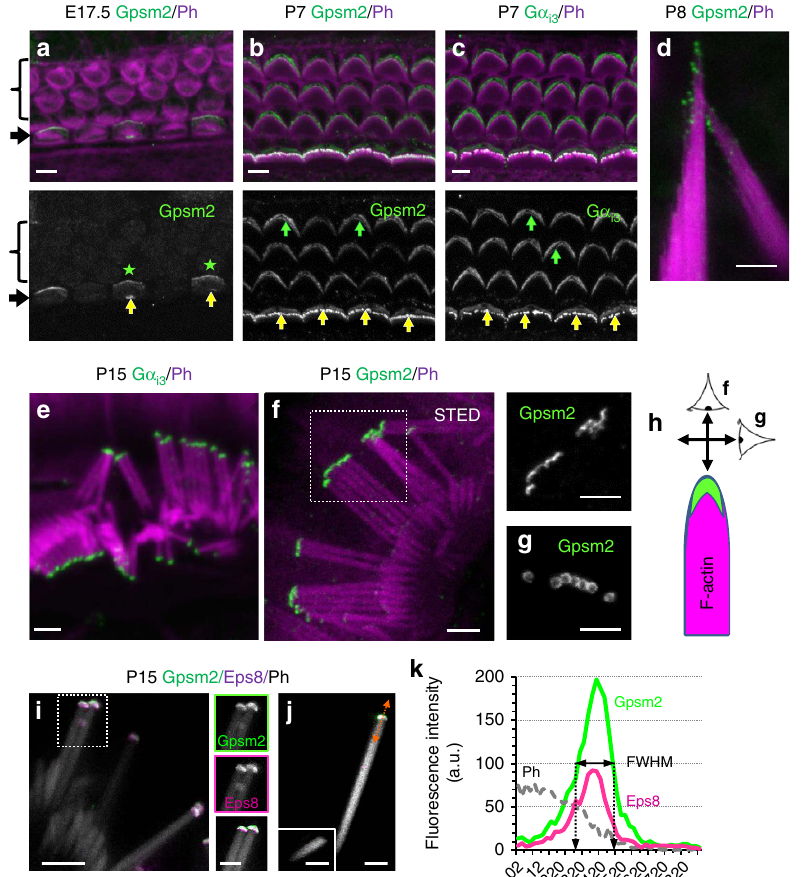
Figure 1 | Gpsm2 and G a i3 are dynamically expressed at the tips of stereocilia. ( a – c ) Surface view of whole mounts of rat cochlear sensory epithelium at E17.5 ( a ) and P7 ( b , c ) illustrating Gpsm2 ( a , b , green) and G a i3 ( c , green) labelling in the actin-rich hair bundle labelled by phalloidin (Ph, magenta). ( a ) At E17.5, Gpsm2 localizes at the tips of stereocilia at the onset of hair bundle growth (yellow arrows), but also in an asymmetrical crescent in a distal region of the apical membrane of HCs (green asterisks). ( b , c ) By P7, both proteins accumulate at tips of stereocilia (green), strongly in IHC (yellow arrows) and more weakly in OHC (green arrows). Arrow: inner hair cell (IHC). Bracket: outer hair cell. Scale bars ( a – c ), 4 m m. ( d ) Gpsm2 (green) is localized at tips of P8 stereocilia of rat vestibular HC bundles. Ph: phalloidin. Scale bar, 2 m m. ( e ) At P15, confocal imaging reveals the accumulation of G a i3 protein at the tip of individual stereocilium. Scale bar 2 m m. ( f – h ) At P15, STED super-resolution imaging of the Gpsm2-expression domain at an individual stereocilium tip ( f ). Gpsm2 accumulated at tips of IHC stereocilia (green), above the F-actin labelling (magenta). ( f , right panel, g ) Acquisition of single plane images in two perpendicular axis as illustrated on the schematic in h reveals the cap-like structure of the Gpsm2 nanodomain. Scale bars, 2 m m. ( i ) Triple STED labelling reveals two mostly overlapping nanodomains at stereocilia tips with Gpsm2 (green) and Eps8 (magenta) above the F-actin signal (Ph, white). Left images: individual channels for Gpsm2 (top) and Eps8 (middle). The bottom image illustrates the phalloidin channel (grey) with two-colour binary representation of Gpsm2 (green) and Eps8 (magenta), with the overlapping domain (plain white). Scale bar, 2 m m. ( j ) Isolated long ( j ) and short ( j , inset) stereocilia illustrate the accumulation of the two proteins in the long stereocilium only. Scale bar, 1 m m. ( k ) Intensity profiles of phalloidin, Gpsm2 and Eps8 from ( j ) (orange line across tip domain). Immunostainings repeated more than six